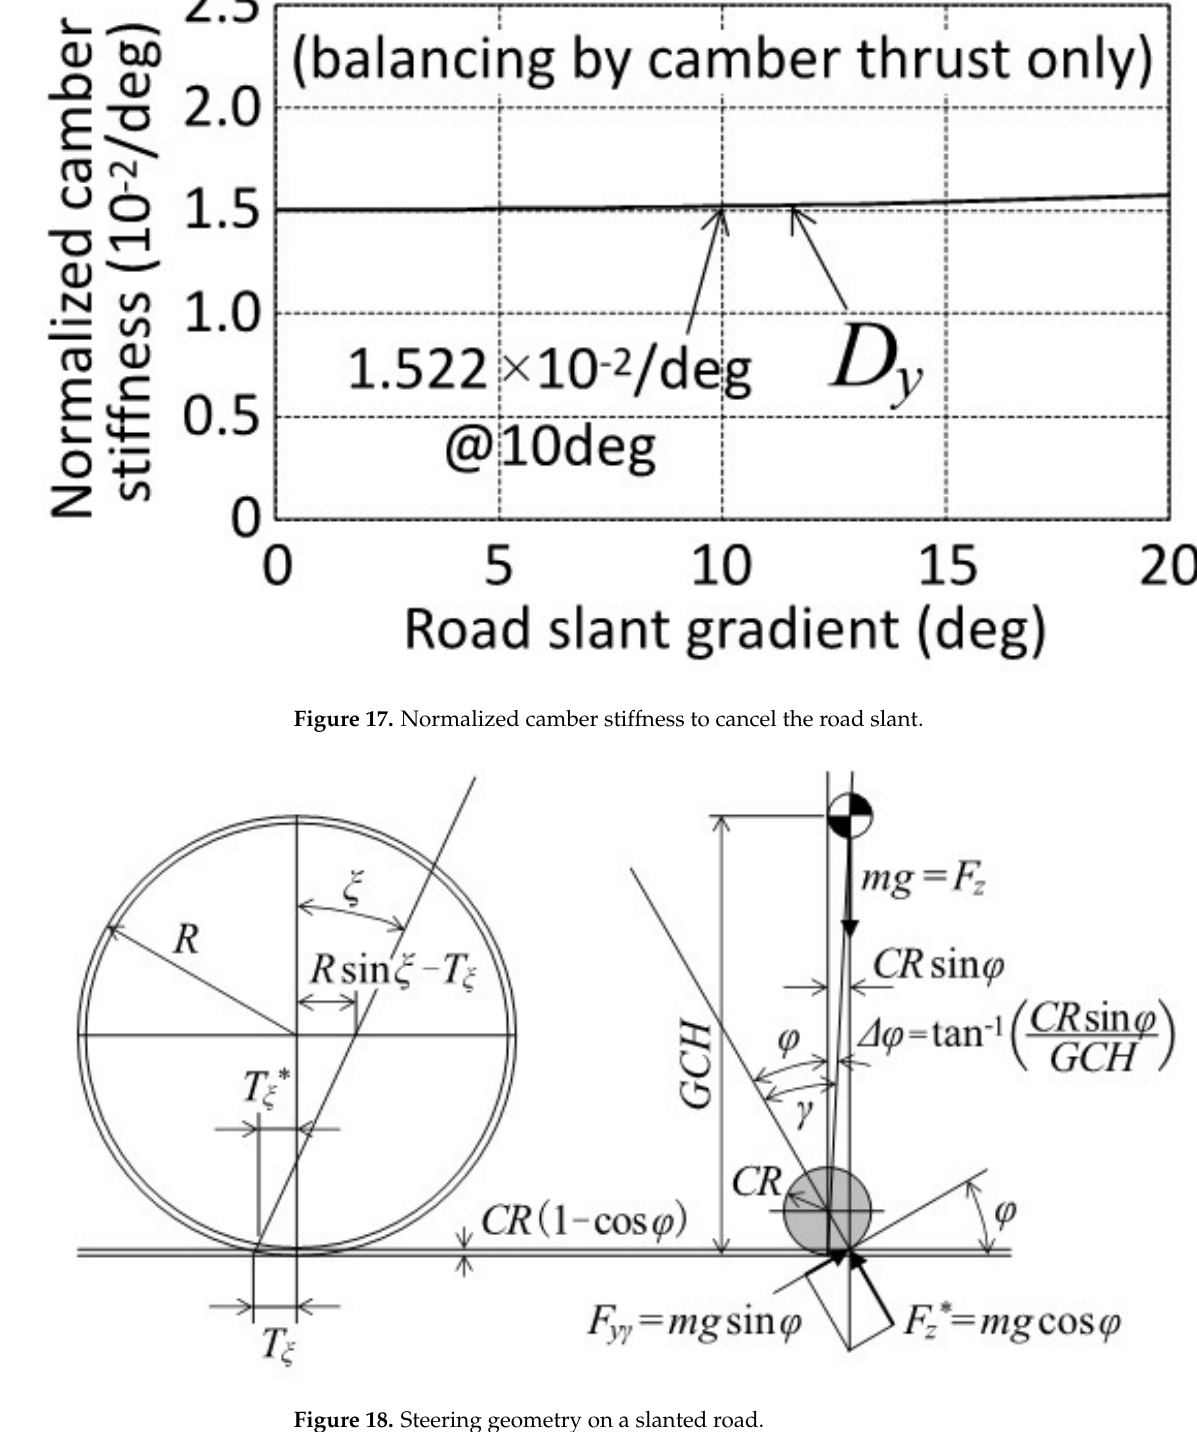
Figure 18. Steering geometry on a slanted